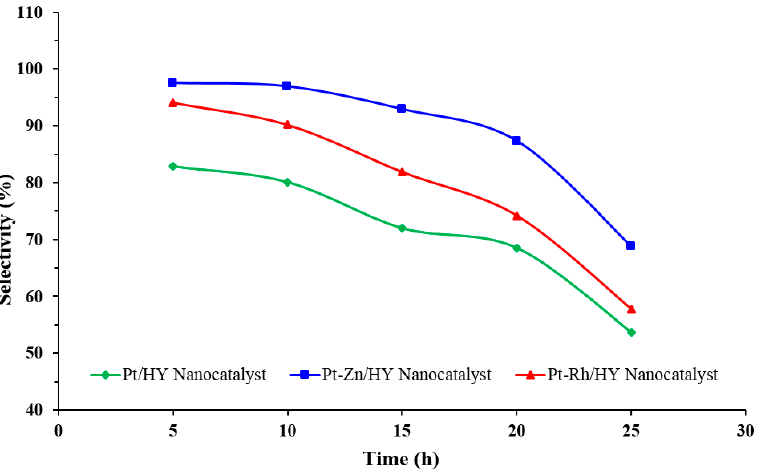
Figure 8. Selectivity of the synthesized nanocatalysts with reaction time at 500 °C, WHSV = 4, and H 2 /HCs = 4.